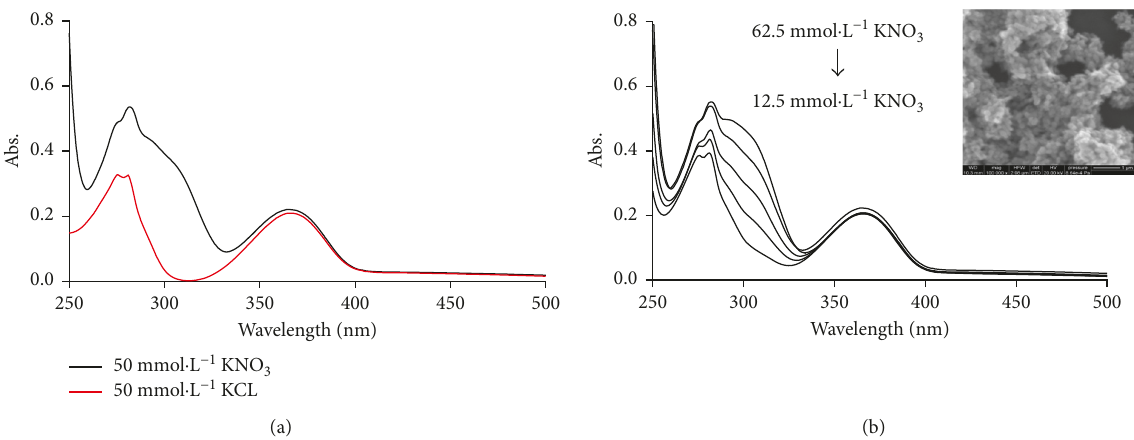
4 mol L · 1 ). − − and 5 × 10 3 (50mmol · L −